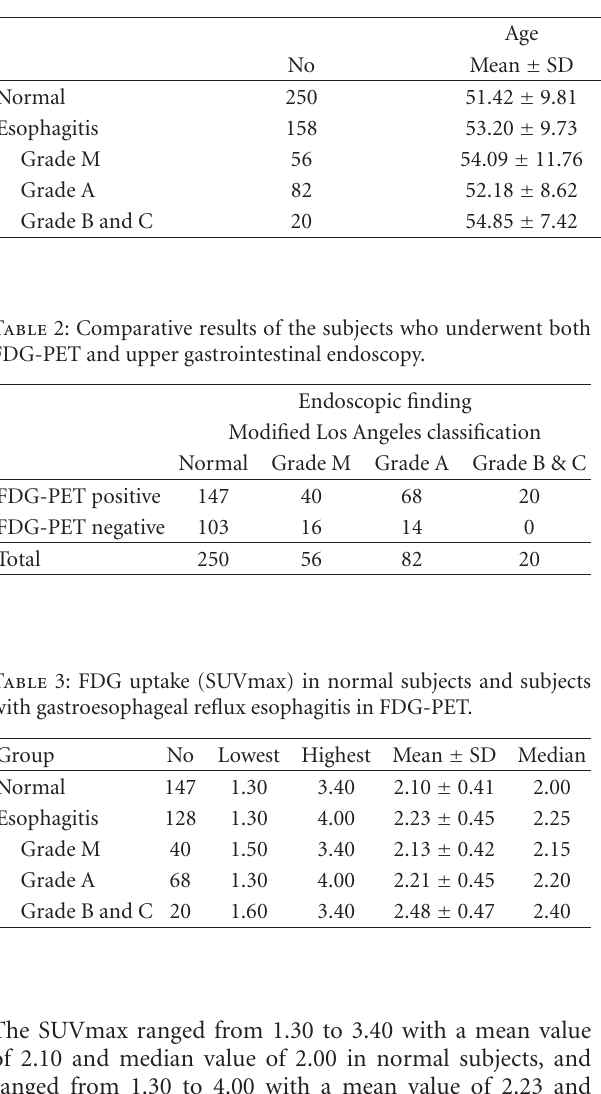
Table 1: Demographic characteristics of the study participants.